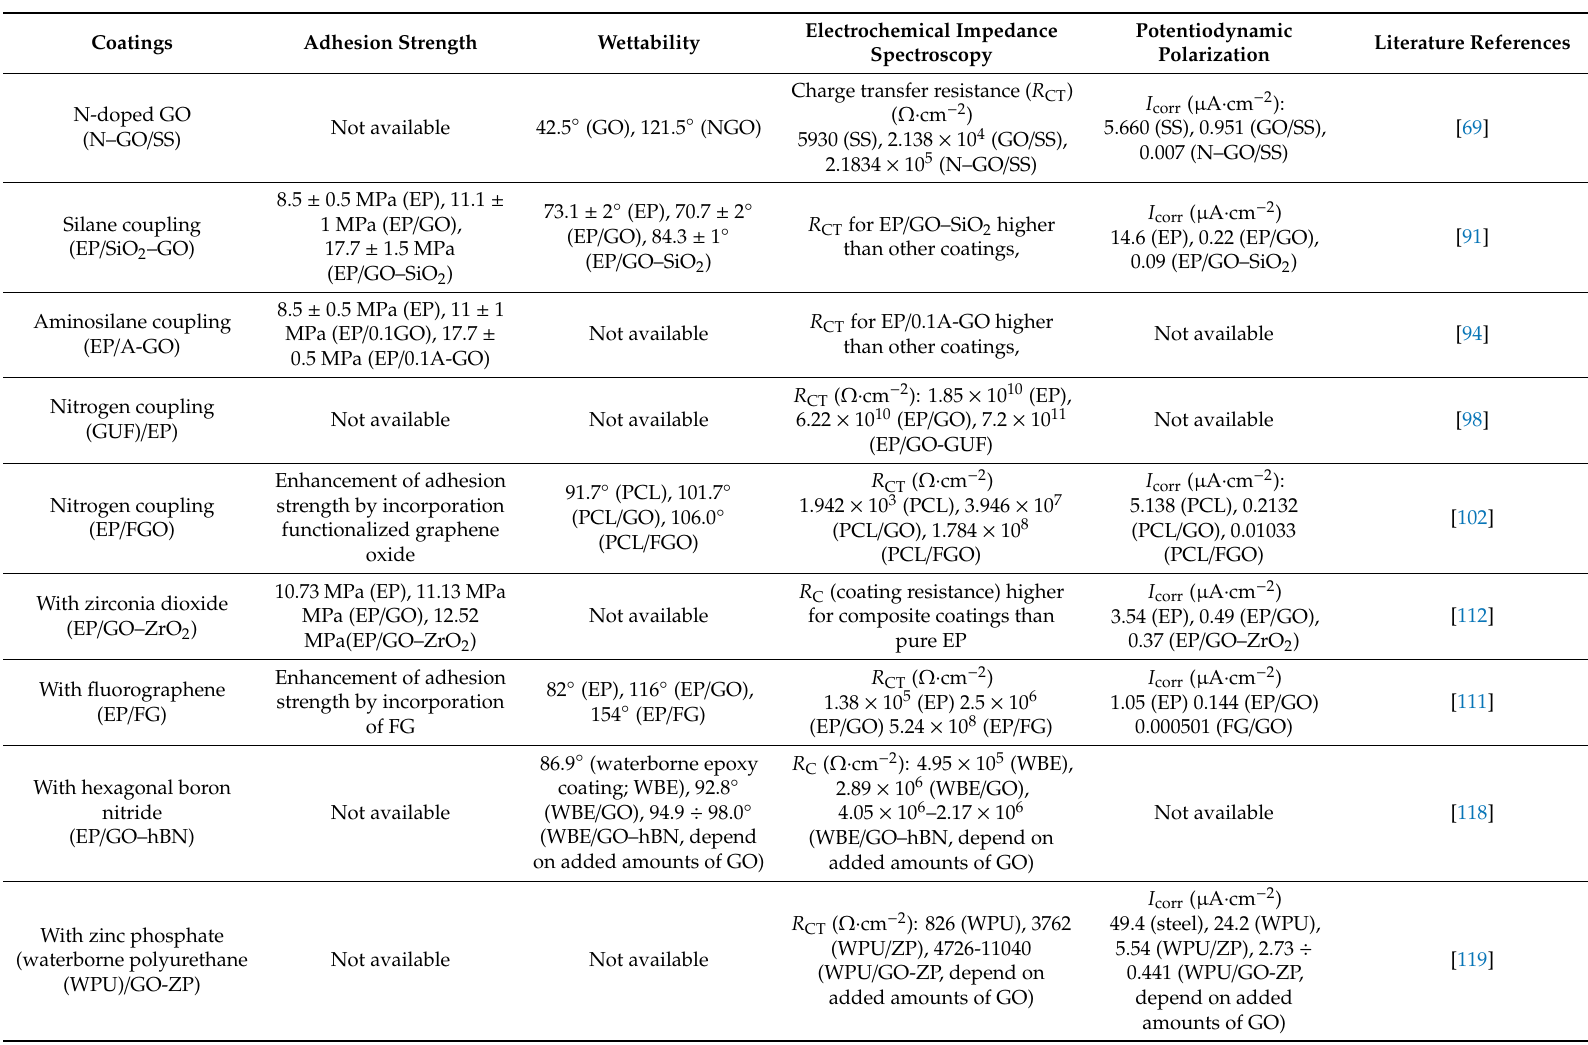
Table 4. Comparison of corrosion resistance between